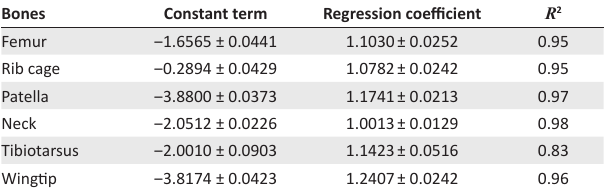
TABLE 4: Allometric coefficients relating the natural logarithms of the weighed bone components to the natural logarithms of empty body protein weight with dietary energy levels as groups to determine the effects on component growth